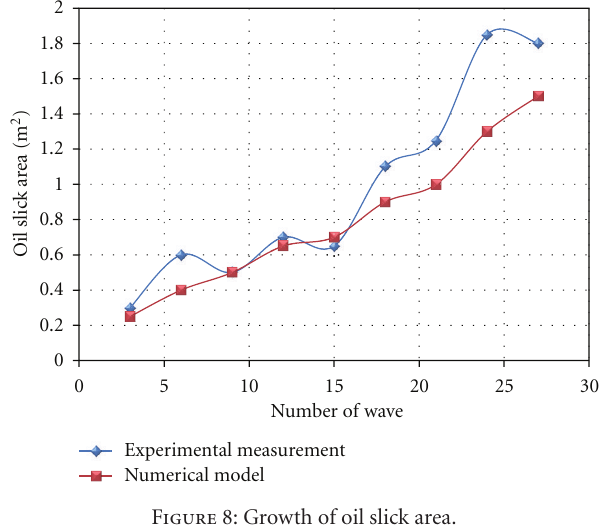
Figure 8: Growth of oil slick area.